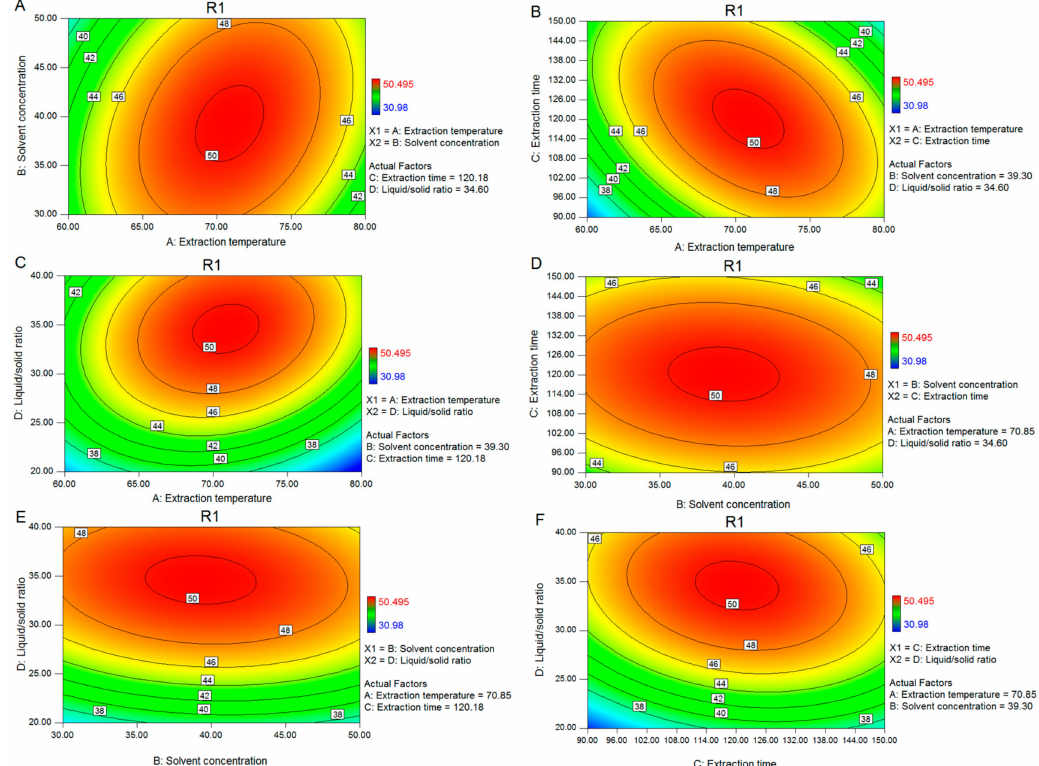
Figure 3. Contour plots showing the e ff ects of the ratio of two single factors. ( A ) Extraction temperature ( ◦ C) versus solvent concentration; ( B ) extraction temperature ( ◦ C) versus extraction time; ( C ) extraction temperature ( ◦ C) versus liquid / solid ratio; ( D ) solvent concentration versus extraction time; ( E ) solvent concentration versus liquid / solid ratio; ( F ) extraction time (min) versus liquid / solid ratio